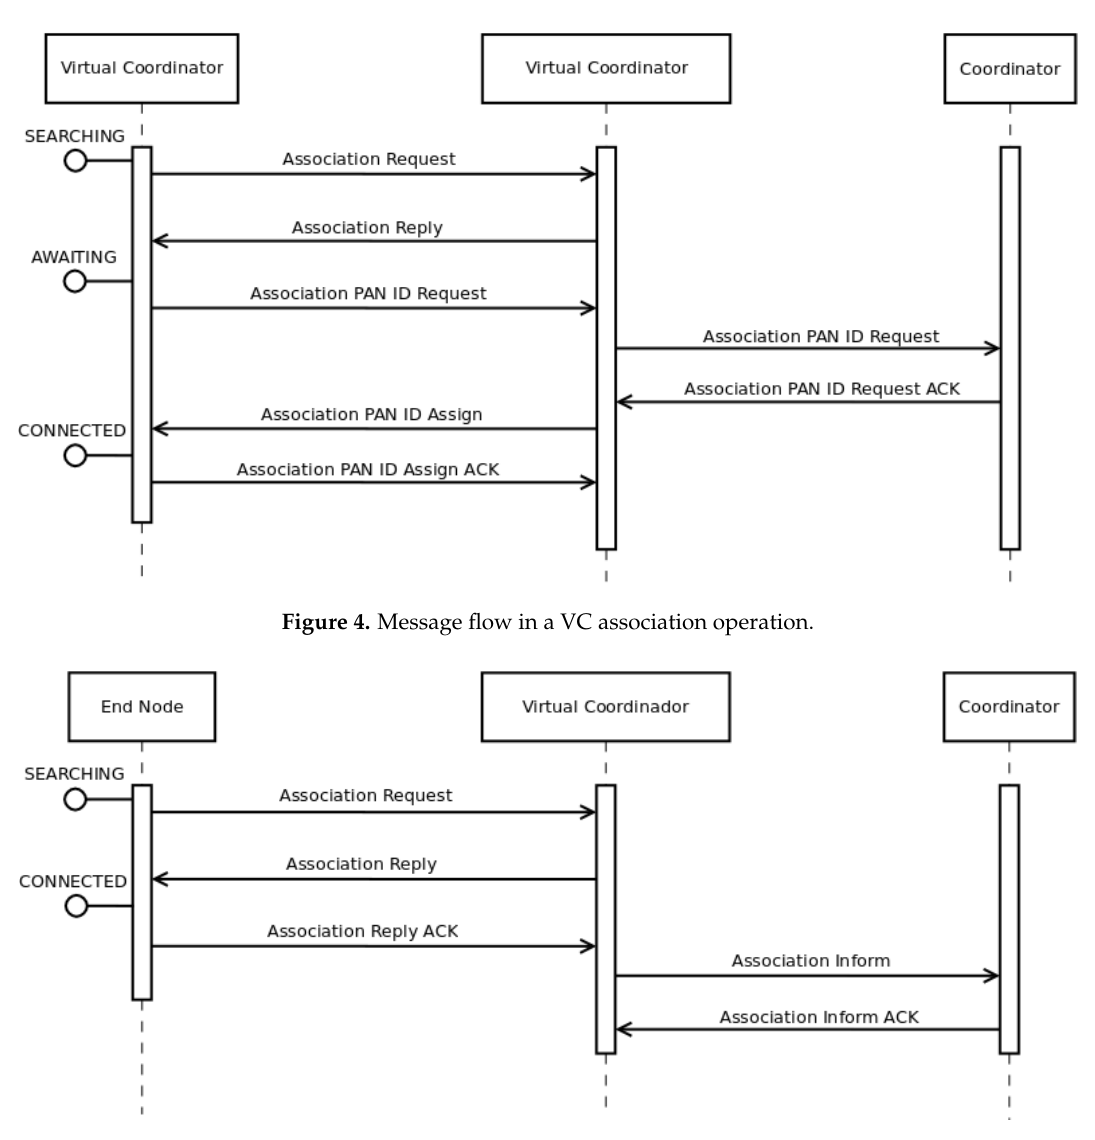
Figure 5. Message flow in an EN association